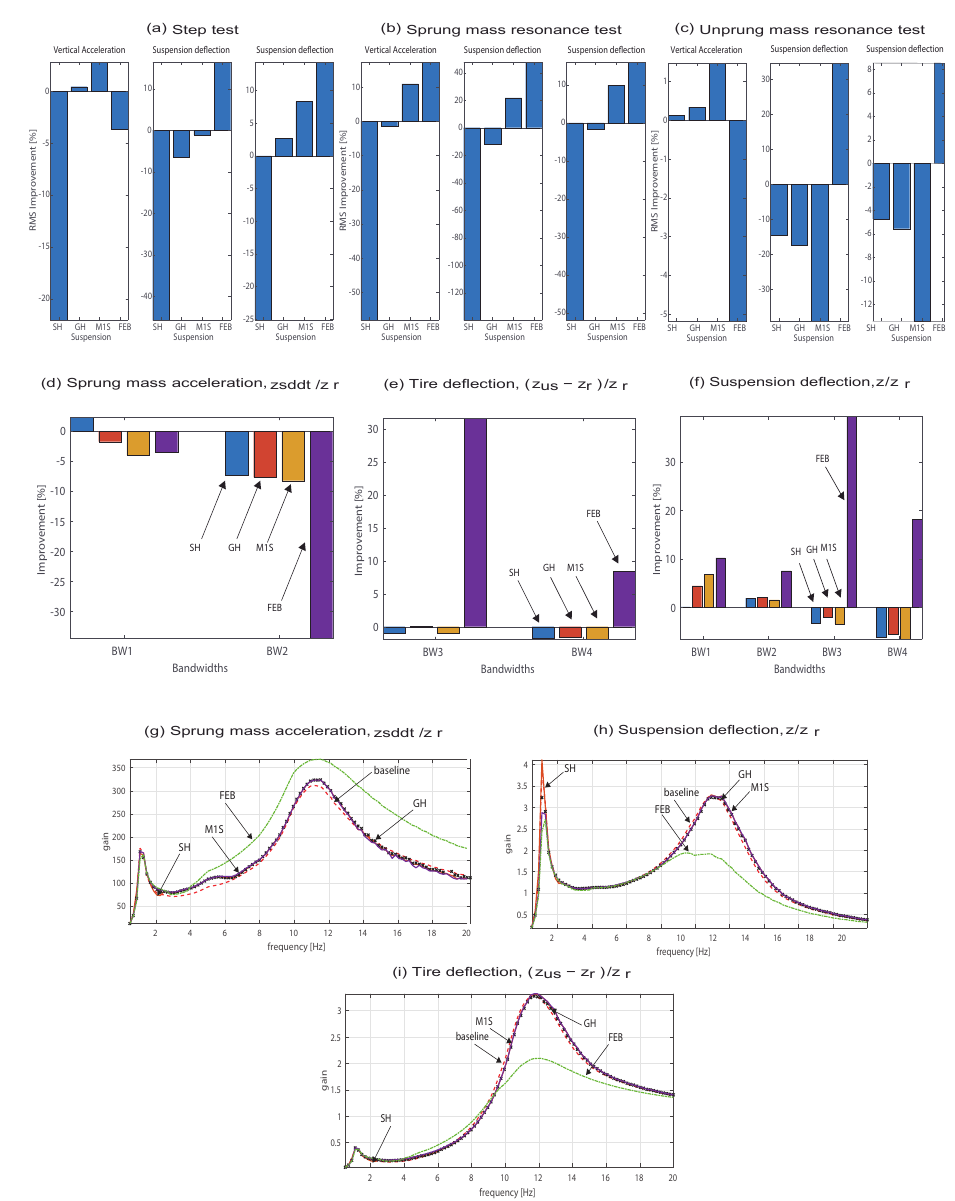
Figure 16. Results from closed simulations for the comparison in a nonlinear QoV model considering